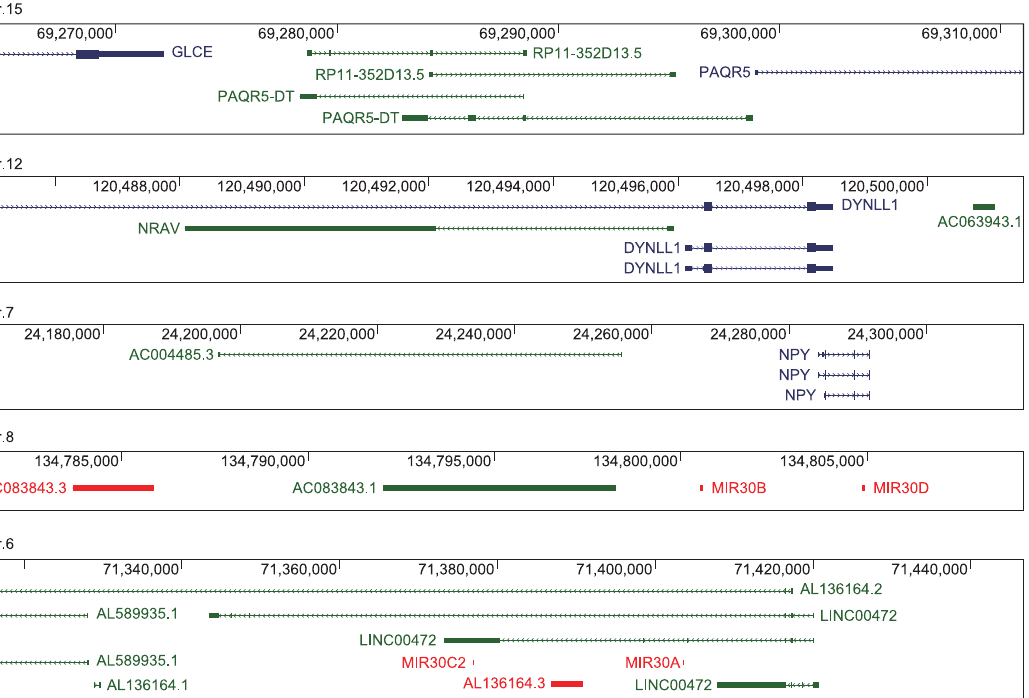
Fig 3. Selected dysregulated lncRNAs identified in the kidney tissues of patients with diabetes. (A) The differences in the expression of these lncRNAs in each group were calculated using the data from the public dataset GSE142025 and reported as FPKM values. (B) Schematics describing the genomic context of each of the lncRNAs as reported in Genome Browser. Blue lines represent protein-coding genes, green lines lncRNA genes, and red lines small non-coding RNA genes.